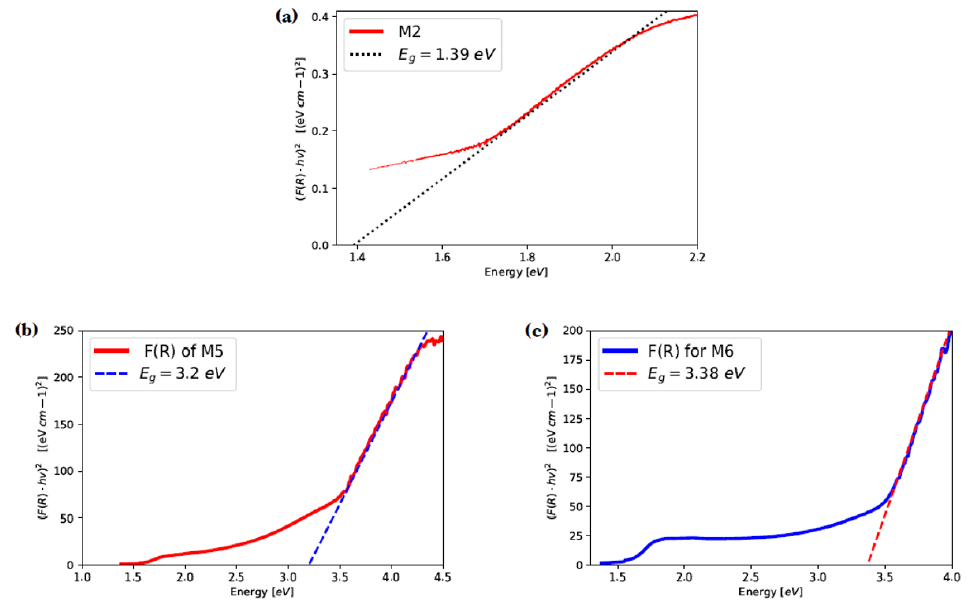
Figure 10. Kubelka–Munk transformed reflectance spectra of samples M2, M5 and M6. ( a )